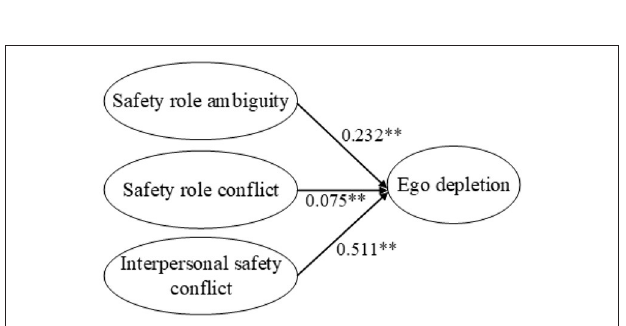
FIGURE 2 | Direct effects of safety stressors on safety performance. ** p < 0.01.